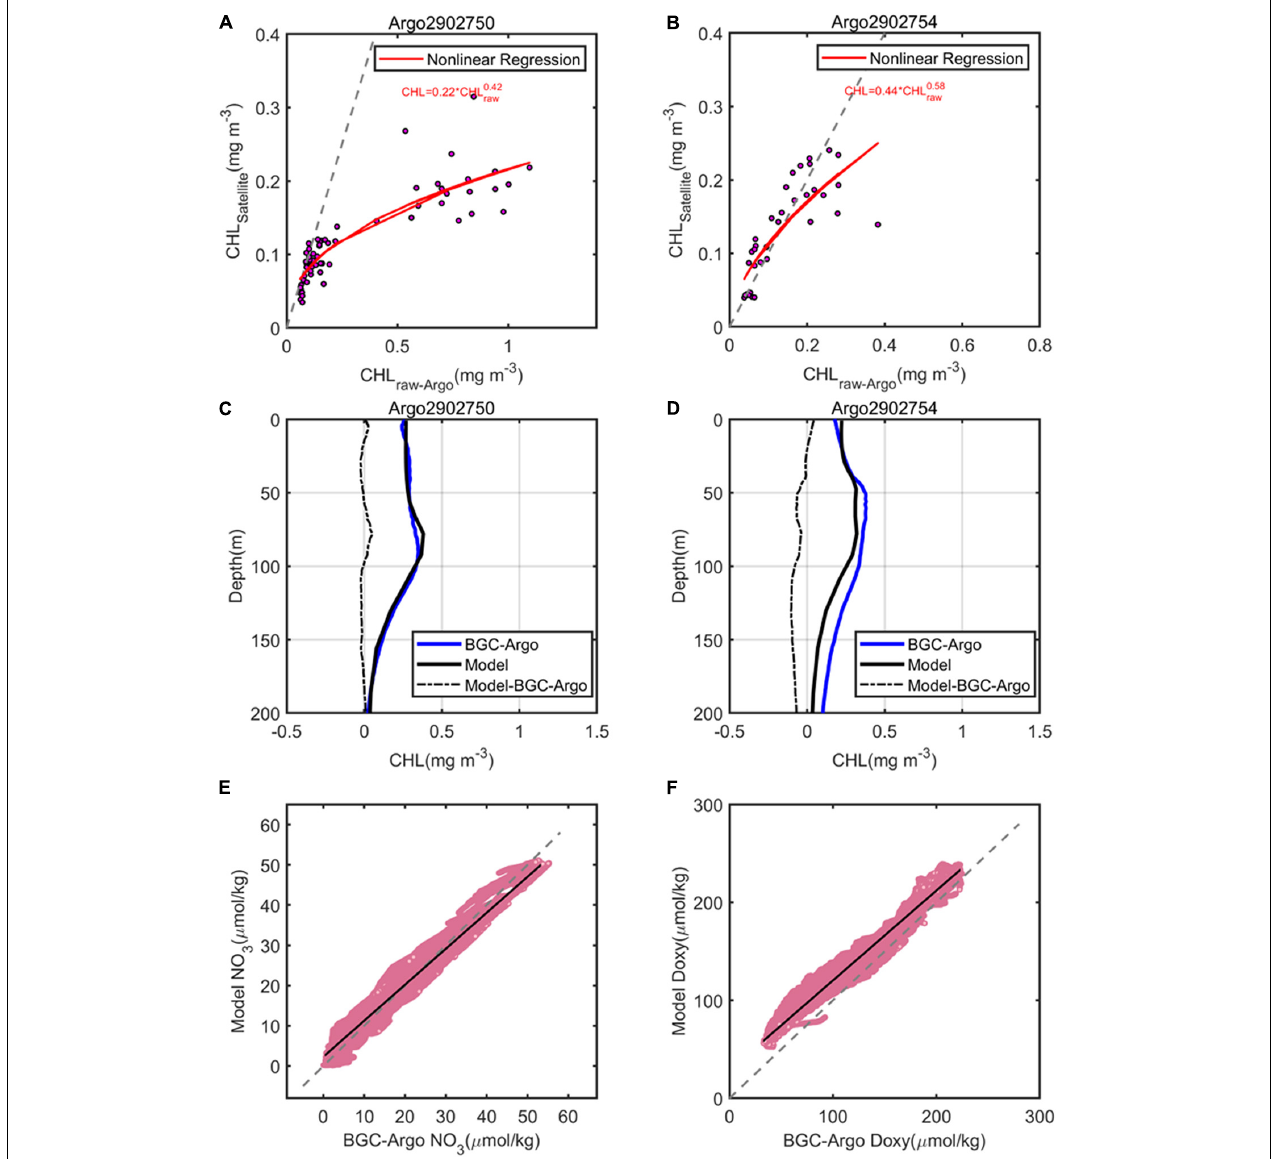
FIGURE 8 | Comparison of (A,B) sea surface satellite CHL and (C,D) temporally averaged vertical profiles of corrected CHL with BGC-Argo 2902750 and 2902754. The red lines represent the nonlinear regression fit, and the dashed gray line represents the 1:1 line in (A,B) . Model versus observed (E) NO 3 and (F) DO concentrations, which show all comparisons from the surface to maximum depth of the BGC-Argo floats listed in Table S1. The black line is the least square regression fit within the data (E,F)